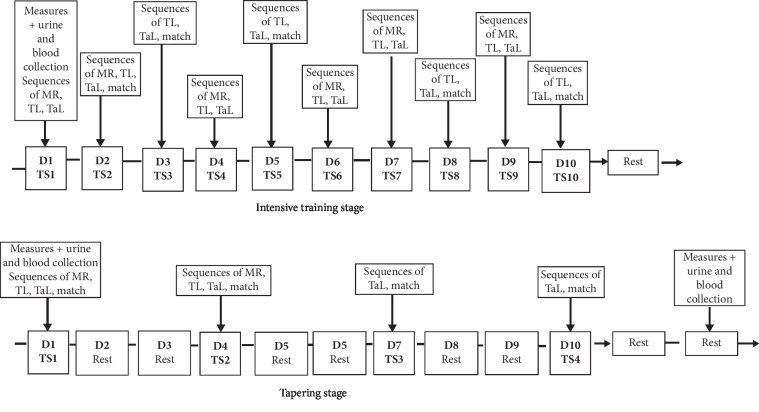
Design and context of the training camp. MR: muscular reinforcement; TL: technical learning; TaL: tactical learning; D: day; TS: training session.